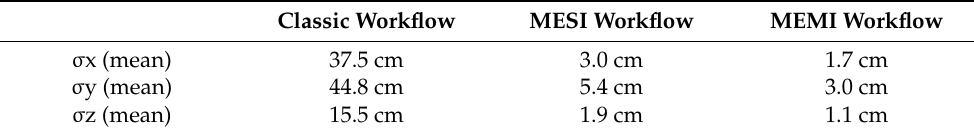
Figure 9. ( a ) Results obtained from the precision estimation test, considering the distribution of σy (depth direction). ( b ) Error boxplots of the range of the precision estimations (note the different scale on the y axis). Table 3. Main results obtained in the precision estimation